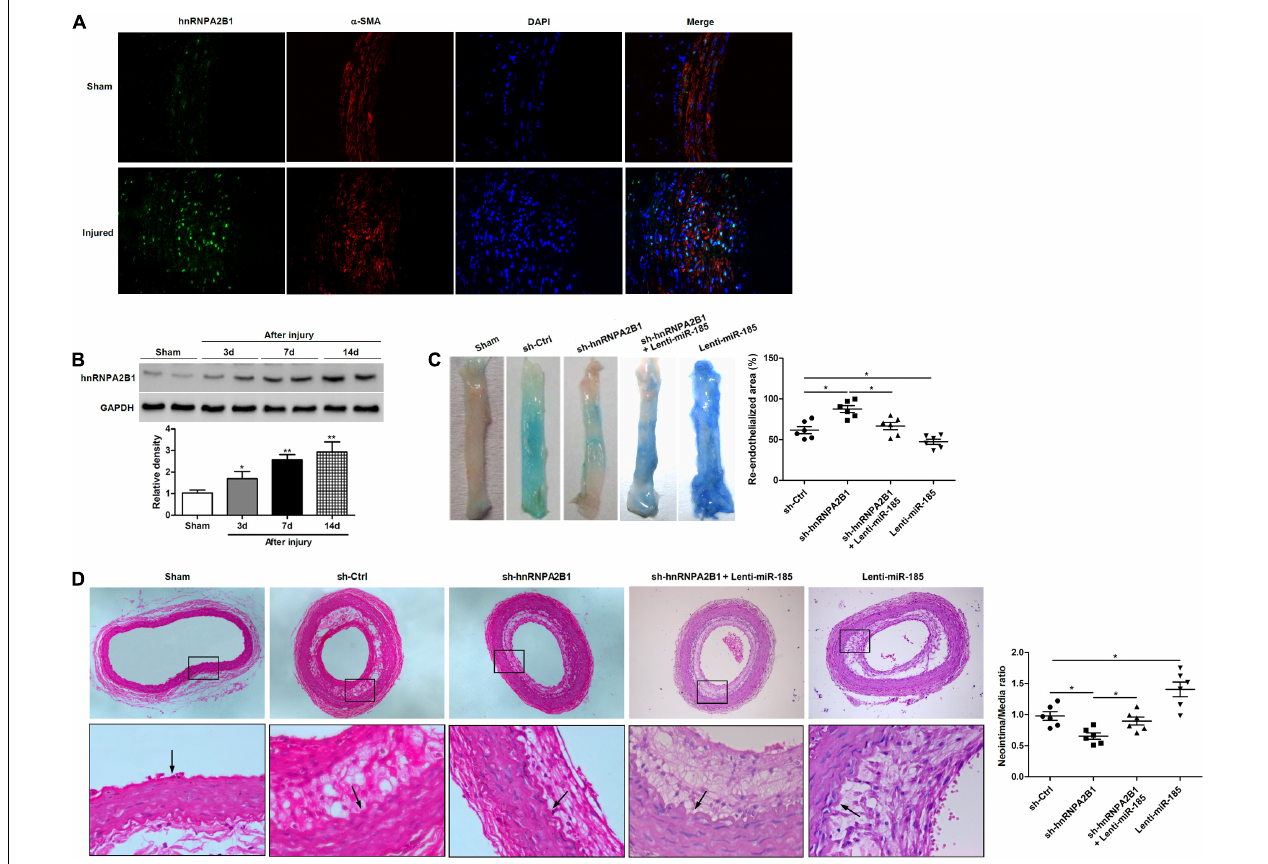
FIGURE 6 | hnRNPA2B1 inhibition promotes re-endothelialization and reduces neointima formation following carotid injury. (A) Immunofluorescence staining shows hnRNPA2B1 (green) expression and localization in the arteries post-injury. (B) Levels of hnRNPA2B1 expression were determined in uninjured rat carotid arteries and at different times after left carotid arterial balloon injury by western blotting. * P < 0.05, ** P < 0.01 vs. Sham group. (C) Representative images of Evan’s blue staining of carotid arteries from rats treated with control shRNA (sh-Ctrl), hnRNPA2B1 shRNA (sh-hnRNPA2B1) carrying lentivirus, sh-hnRNPA2B1 and Lenti-miR-185, or Lenti-miR-185 at day 7 after balloon injury. (D) Representative images of hematoxylin and eosin-stained paraffin sections of carotid arteries from rats treated with control shRNA (sh-Ctrl), hnRNPA2B1 shRNA (sh-hnRNPA2B1) carrying lentivirus, sh-hnRNPA2B1 and Lenti-miR-185, or Lenti-miR-185 at day 14 after balloon injury. Arrows indicate the internal elastic lamina. Quantifications of neointimal formation as intima/media area ratio are shown. * P <